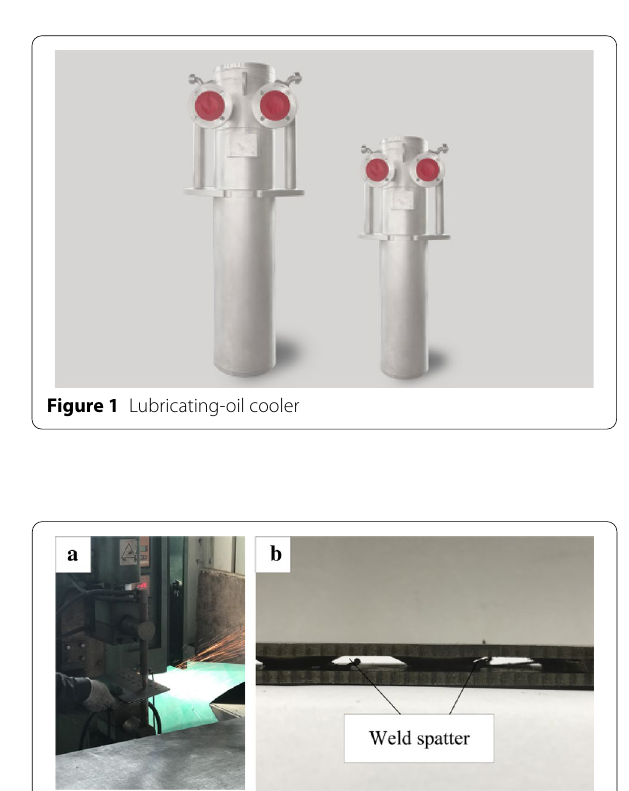
Figure 2 Resistance spot welding process and internal section photos of the sealed cavity: a Spatter during welding; b Deposition of splashes in the